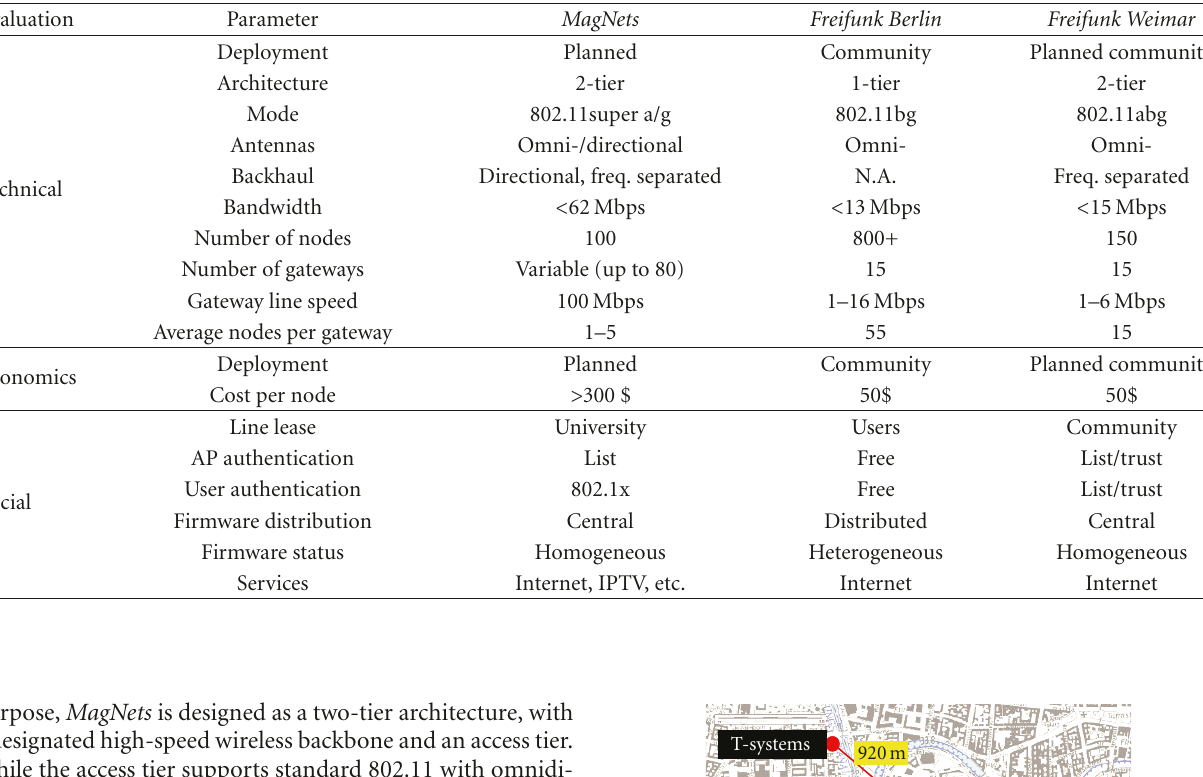
Table 1: Comparison of wireless mesh networks in Germany.